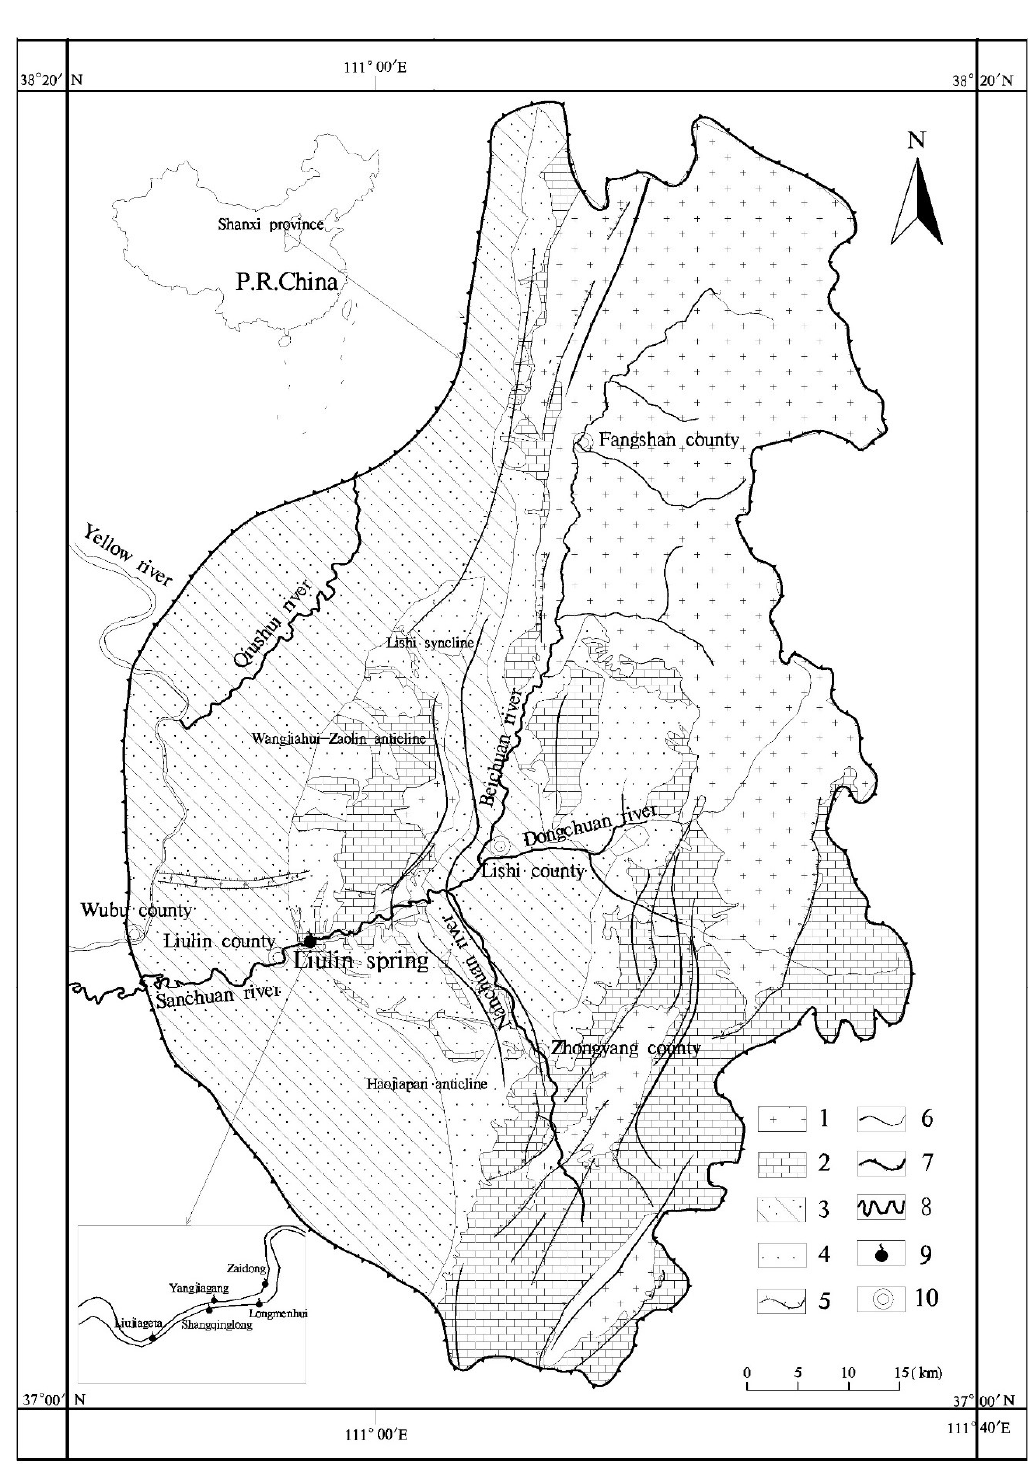
Figure 1. Simplified geological map of Liulin karst water system with an enlarged view of the locations of springs. 1: Precambrian metamorphic rocks; 2: Cambrian and Ordovician carbonate rocks; 3: Carboniferous-Triassic clastic rocks; 4: Neogene-Quaternary rickle; 5: fault; 6: fold; 7: boundary of spring area; 8: river; 9: spring; 10: city.